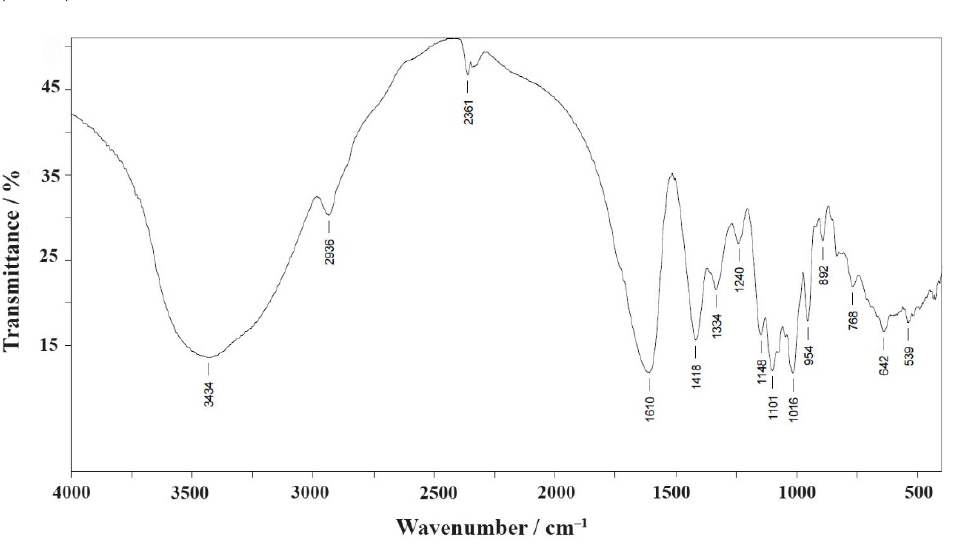
Figure 4. Fourier-transform infrared spectroscopy spectrum of the copper pectin complex (PG-